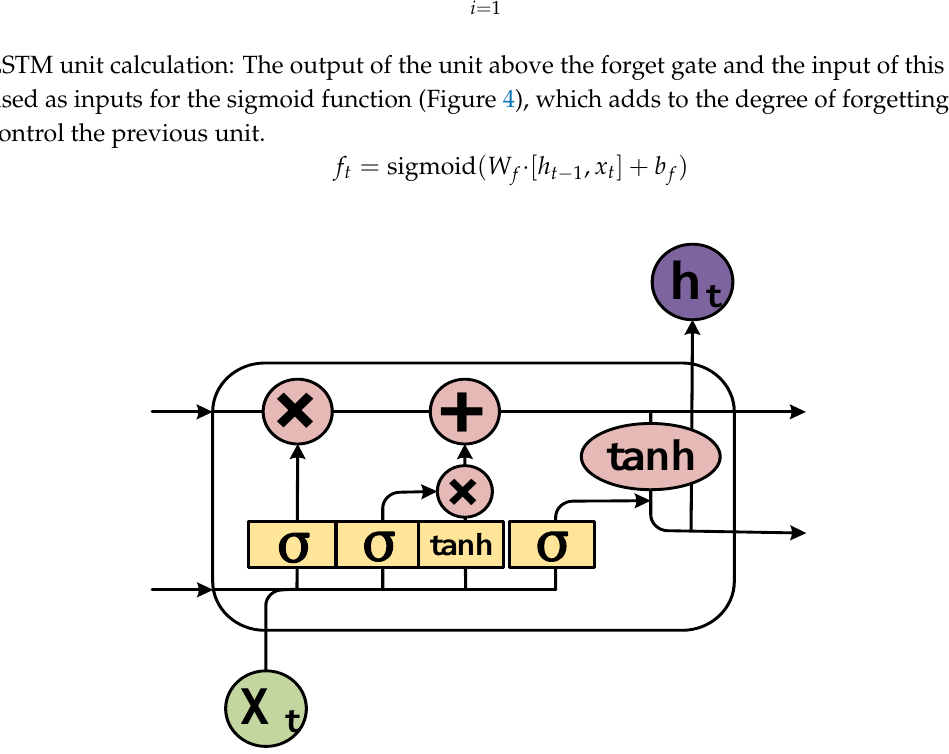
Figure 4. Internal schematic of an LSTM cell unit.